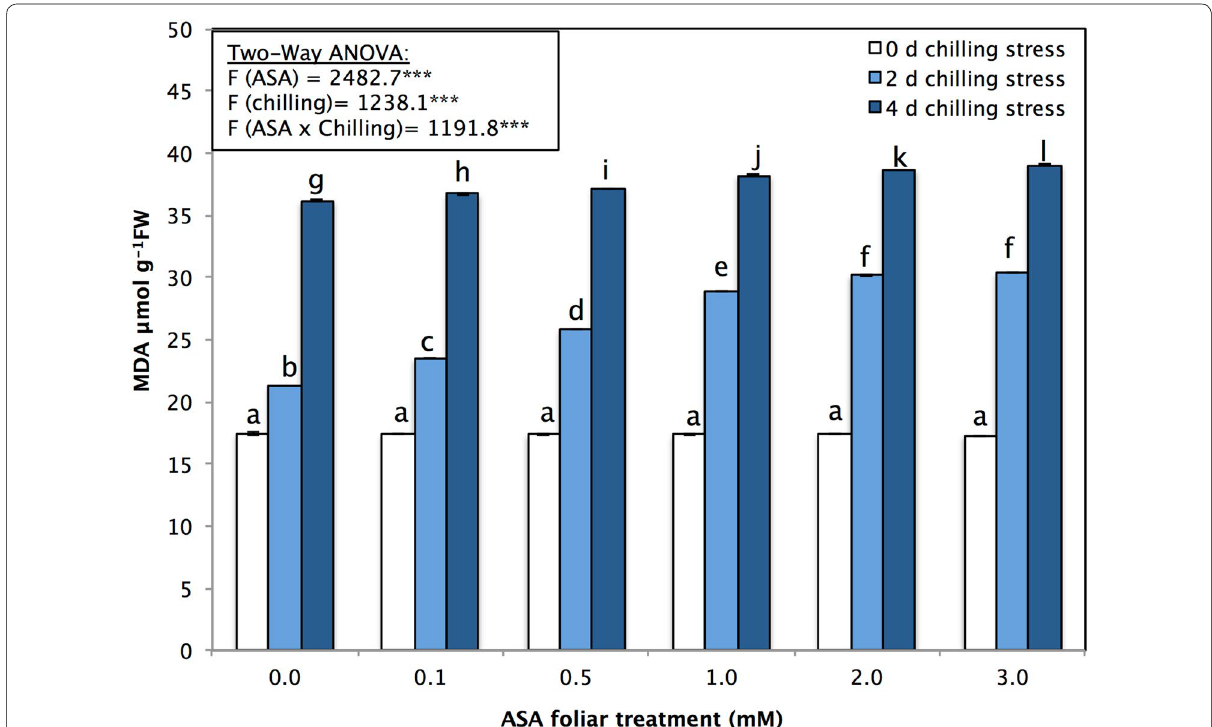
Fig. 3 Cellular lipid peroxidation in terms of MDA (μmol g − 1 FW) of P. vulgaris L. after foliar application of different concentration of acetylsalicylic acid (ASA; 0, 0.1, 0.5, 1, 2, 3 mM) and exposed to different level of chilling stress (0, 2, 4 days). Data represented are mean of two replicates ard deviation. Variations between different chilling stresses and foliar ASA concentration were assessed by univariate analyses followed by post hoc analysis. Means with the same letters are not significantly different according to Duncan’s multiple